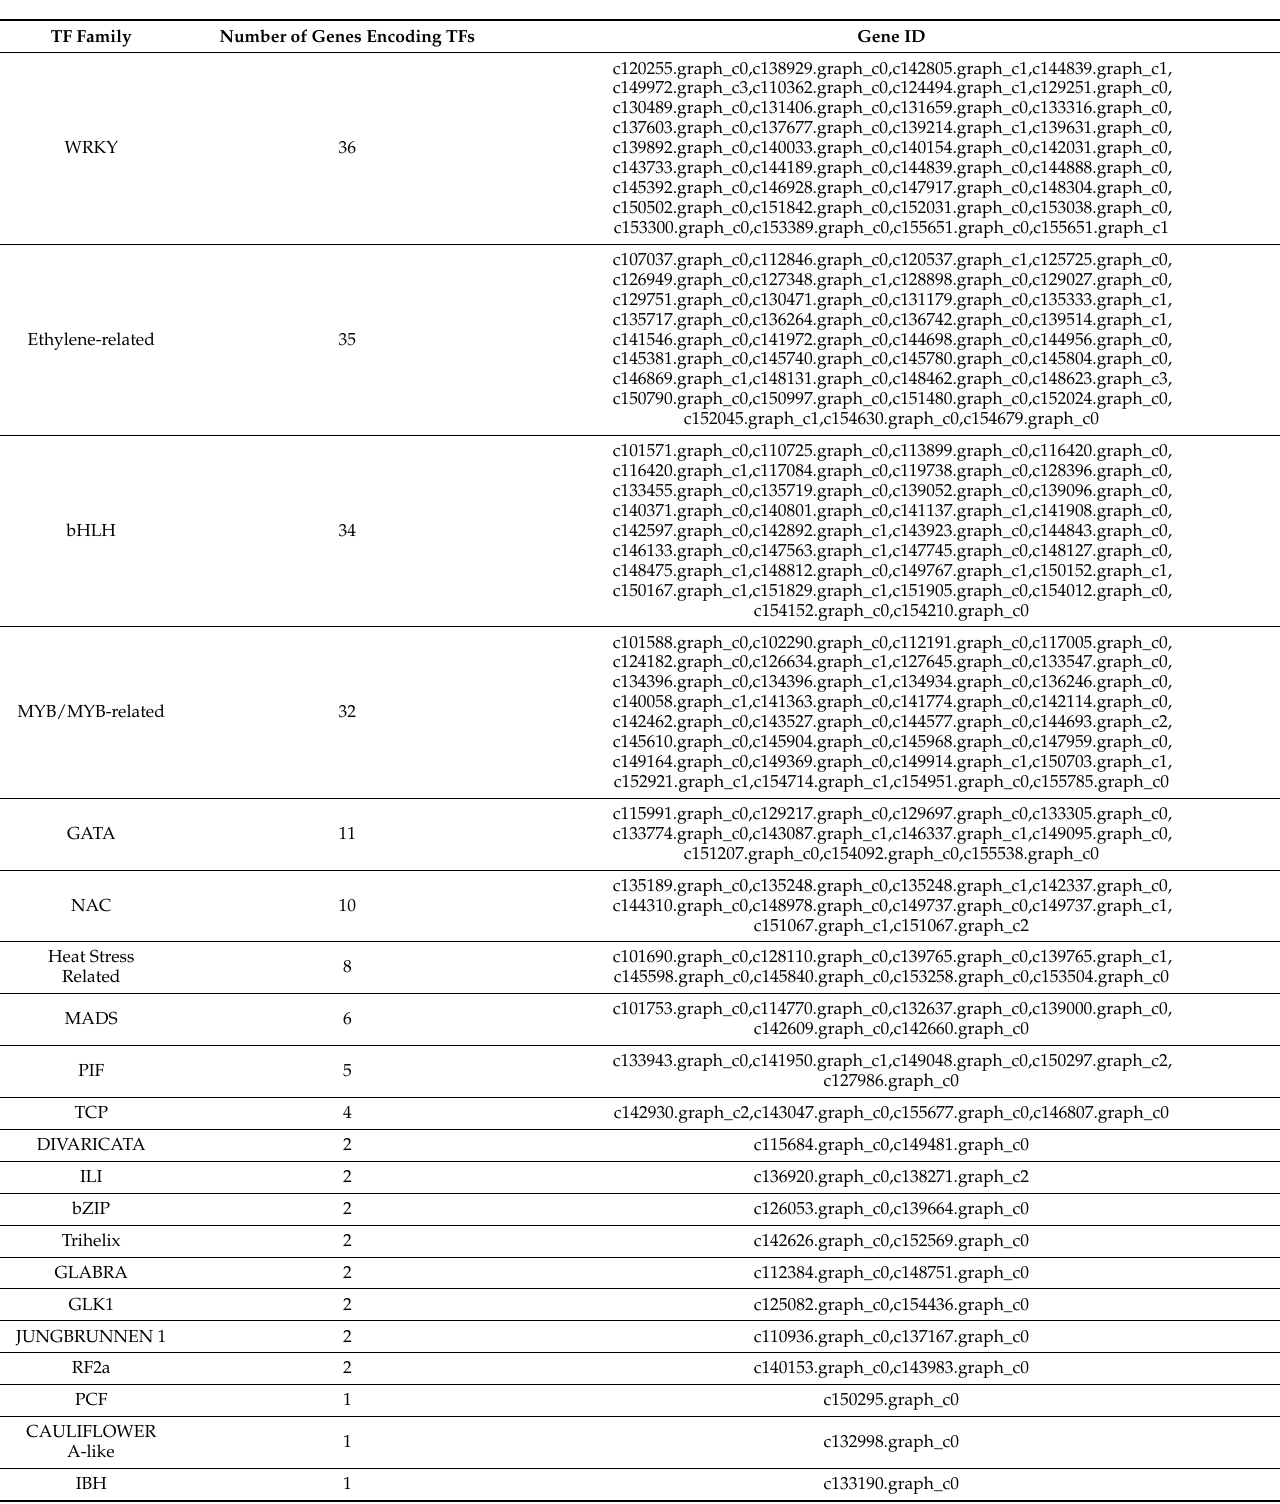
Table 4. List of 200 putative TFs differentially expressed between ‘Jinzhan Yintai’ and the yellow mutant